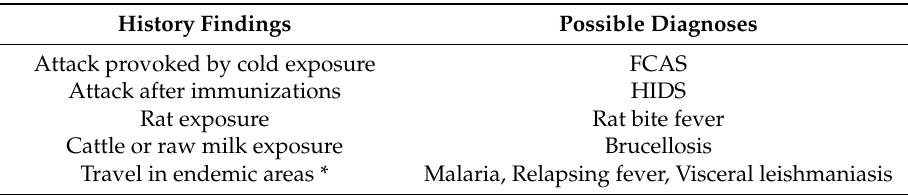
Table 2. Case history findings suggestive of a specific diagnosis.